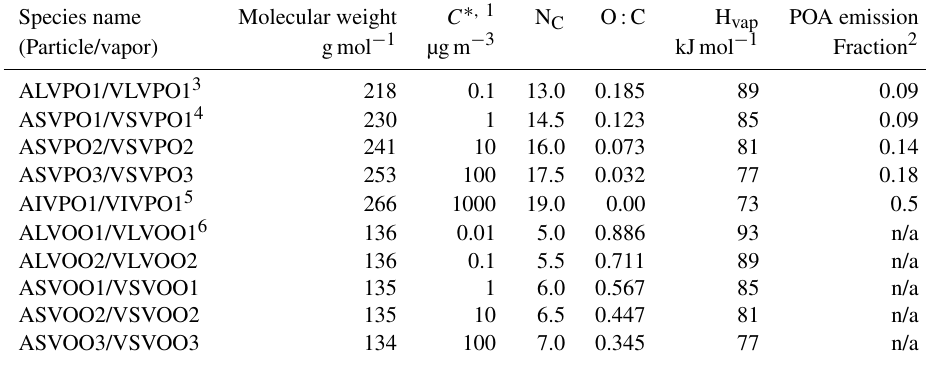
Table 1. Properties of semivolatile POA species in CMAQv5.2. Species